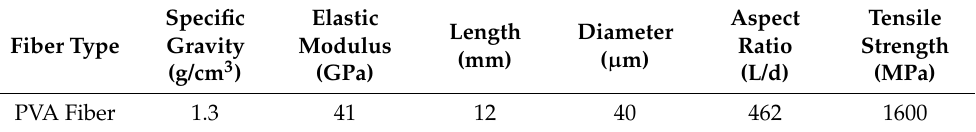
Table 3. PVA fiber physical properties.